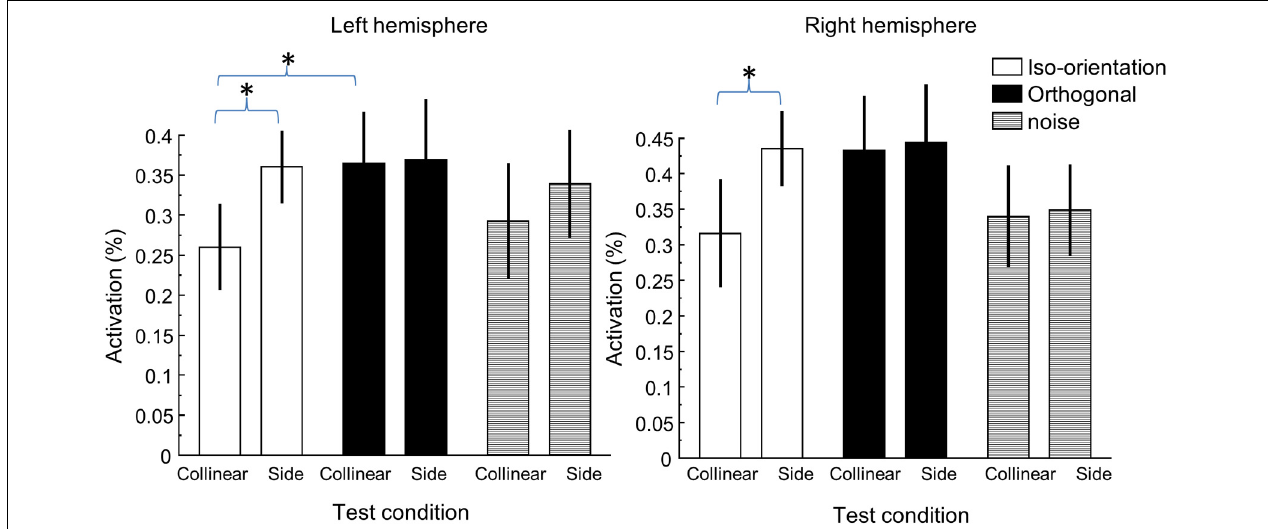
FIGURE 4 | The peak activation under various flanker conditions. The left panel shows the activation in the left hemisphere ROI and the right panel shows the activation in the right hemisphere ROI. ∗ Denotes statistically significant difference at 0.05 level.